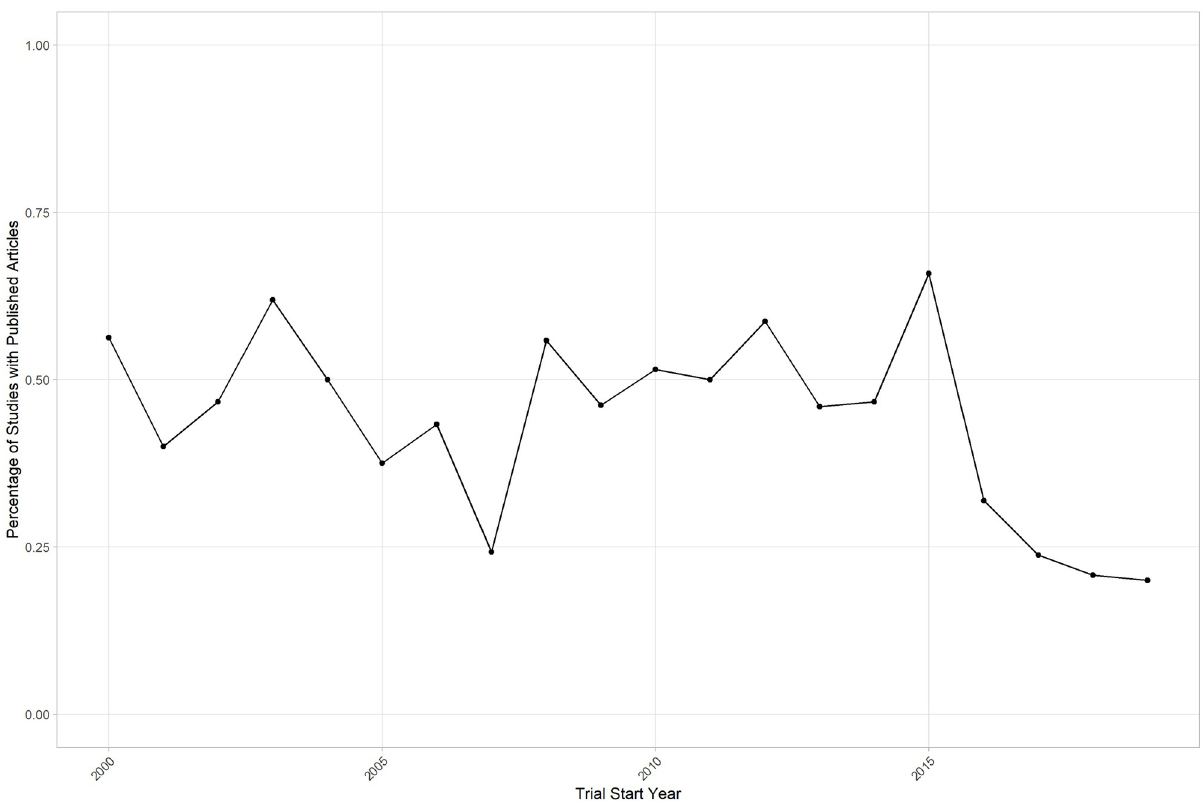
Fig 3. Percentage of trials with published scientific articles in the manually inspected